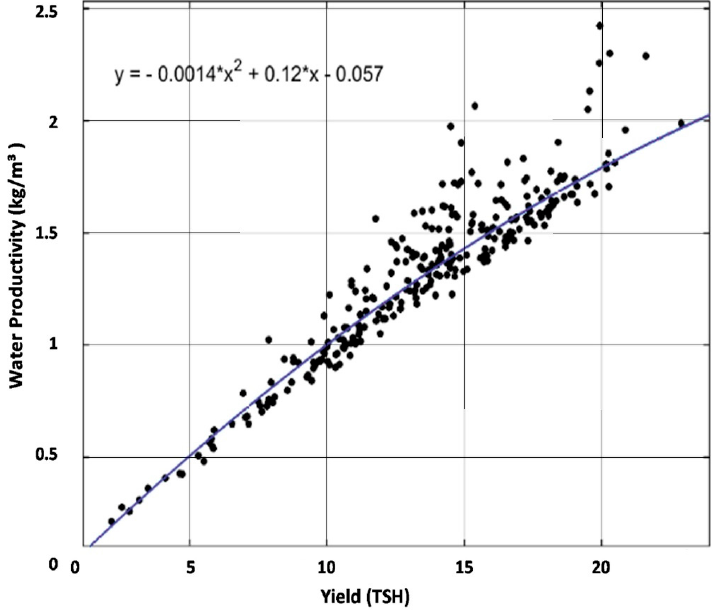
Figure 8. A plot of sugarcane yield versus water productivity calculated using ET